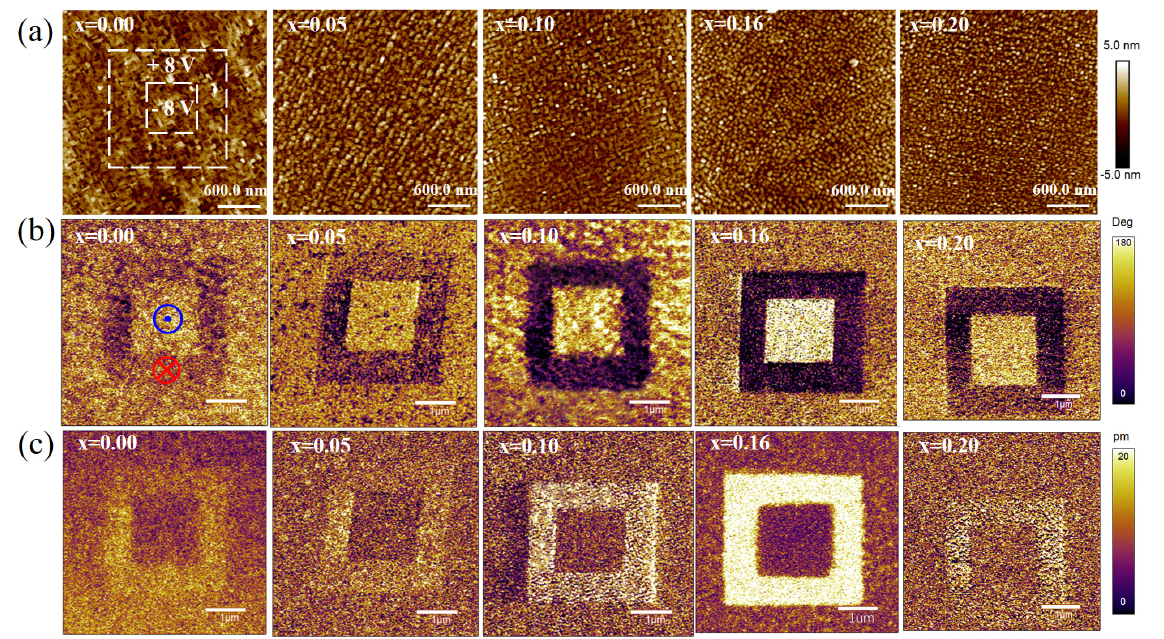
Figure 2. ( a ) The 2D AFM images of BNFMO (x = 0.00~0.20) thin films. ( b ) PFM phase and ( c ) amplitude plots of BNFMO (x = 0.00~0.20) thin films.